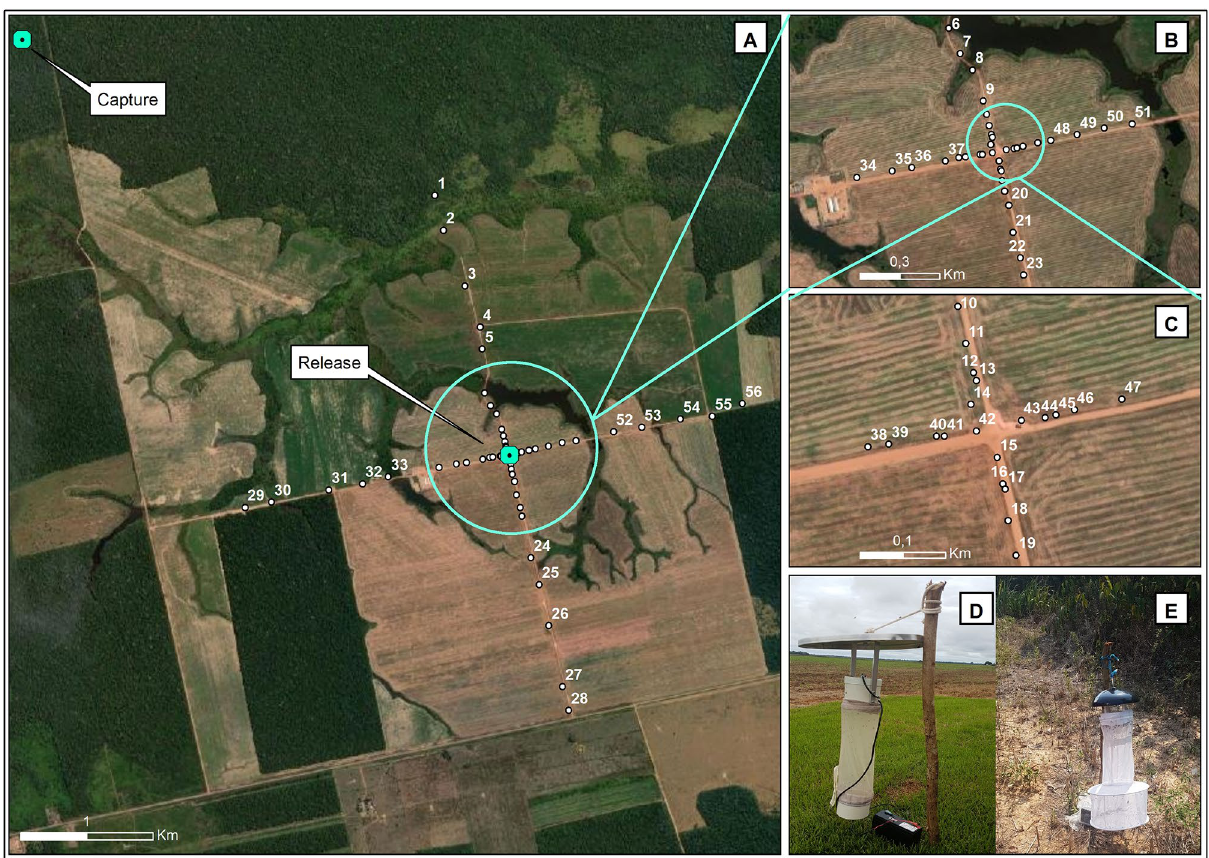
Figure 2. Sample design of the launch sites in the surrounding area of the Amazon Jirau Hydroelectric Power Plant (UHE-Jirau), Jaci-Paraná district, Porto Velho, Rondônia state, Brazil. ( A ) 1, 29 (Mf-60), 28, 56 (CDC) = 2000 m; 2, 30 (CDC), 27, 55 (Mf-60) = 1800 m; 3, 31 (Mf-60), 26, 54 (CDC) = 1300 m; 4, 32 (CDC), 25, 53 (Mf-60) = 1000 m; 5, 33 (Mf-60), 24, 52 (CDC) = 800 m; ( B ) 6, 34 (CDC), 23, 51 (Mf-60) = 500 m; 7, 35 (Mf- 60), 22, 50 (CDC) = 400 m; 8, 36 (CDC), 21, 49 (Mf-60) = 300 m; 9, 37 (Mf-60), 20, 48 (CDC) = 200 m; ( C ) 10, 38 (CDC), 19, 47 (Mf-60) = 150 m; 11, 39 (Mf-60), 18, 46 (CDC) = 100 m; 12, 40 (CDC), 17, 45 (Mf-60) = 70 m; 13, 41 (Mf-60), 16, 44 (CDC) = 60 m; 14, 42 (CDC), 15, 43 (Mf-60) = 30 m; ( D ) CDC-type traps; ( E ) MF-60 light trap with